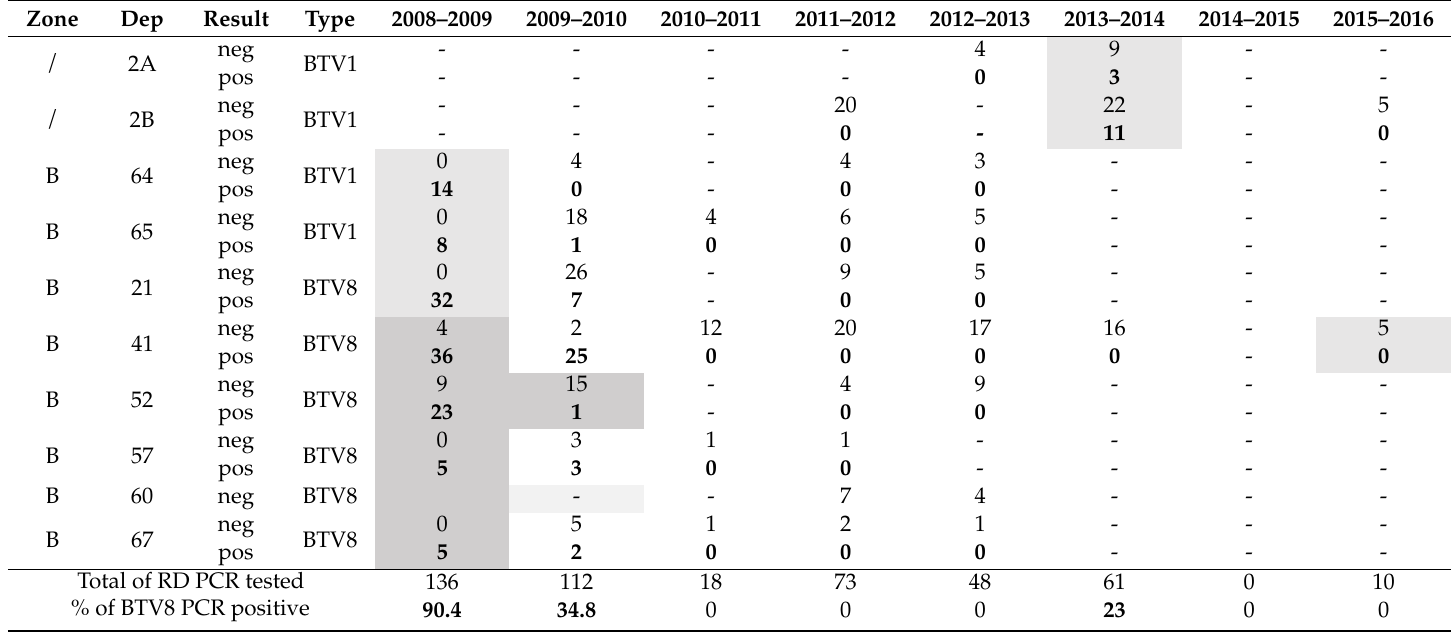
(b) PCR results observed among 458 c-ELISA positive RD (spleens or full